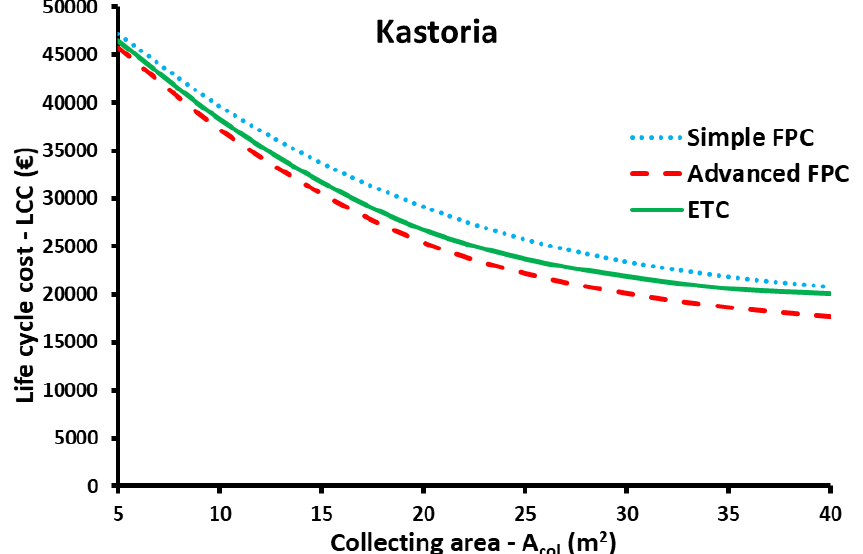
Figure 22. Life cycle cost for different collecting areas and collector types for Kastoria.